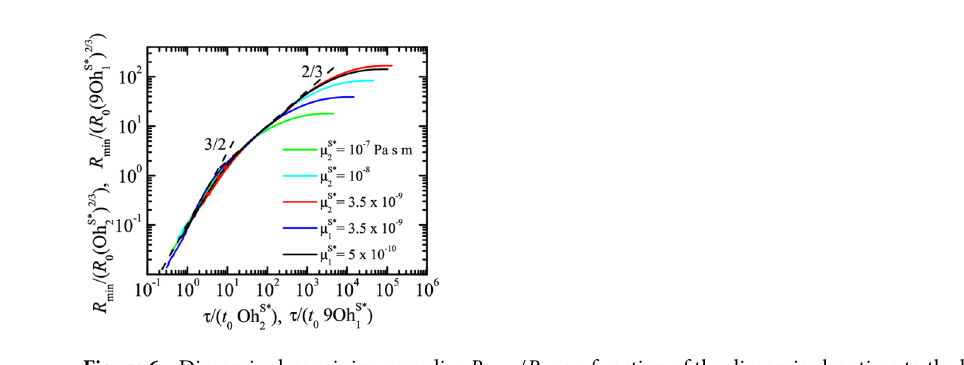
S Ŵ | ) (solid symbols), and the surface velocity S ( z ) (cid:31) (upper graph) and free surface radius S ∗ 0 , µ S ∗ 3.5 × 10 − 9 Pa s m } . The values of the 1 = 2 = Ŵ cmc = 1.002 , Pe S = 7.730 × 10 4 , Oh S ∗ 1 = 0 , (cid:31)